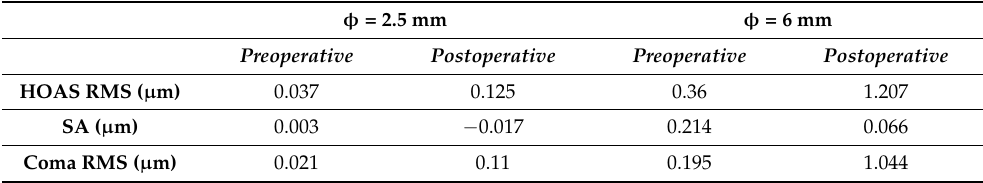
Table 6. Preoperative and postoperative RMS HOAS, SA and RMS coma values of Eye 3 for 2.5 mm and 6 mm pupil